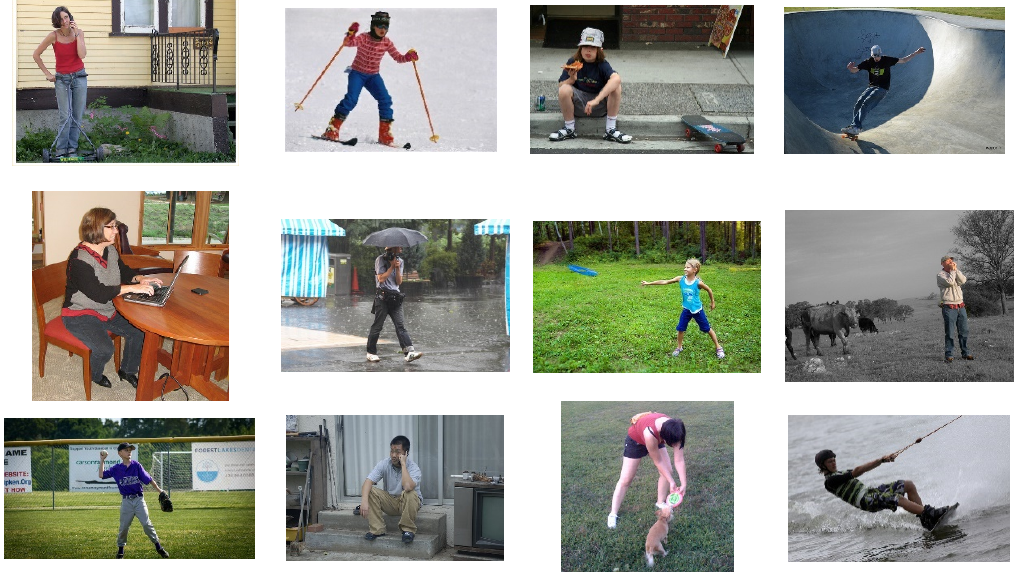
Figure 1. Sample images from the COCO dataset.